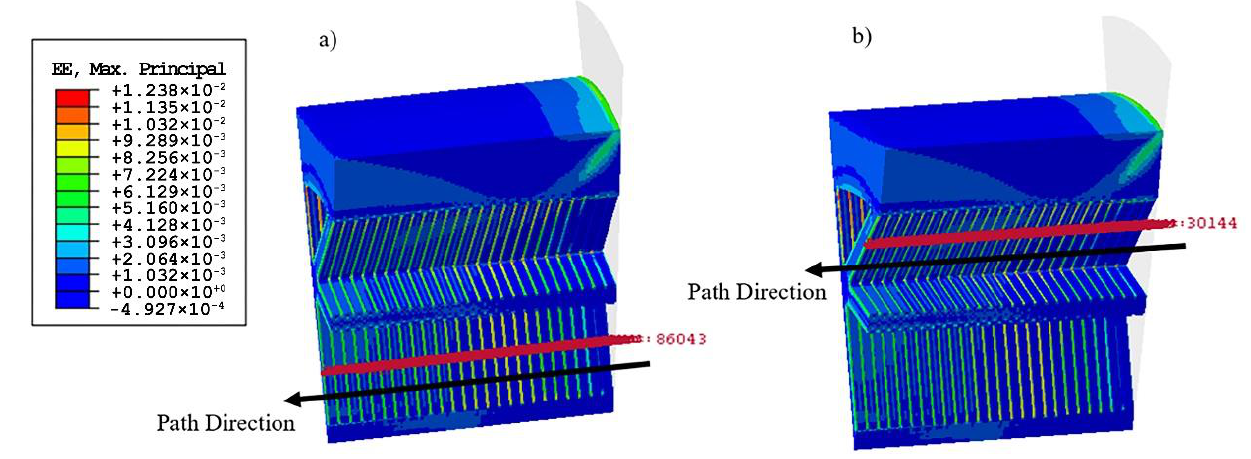
Figure 13. The paths examined in this simulation: ( a ) Path 1 and ( b ) Path 2.